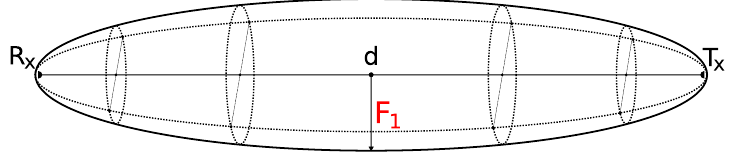
Figure 7. Representation of the first Fresnel Zone.